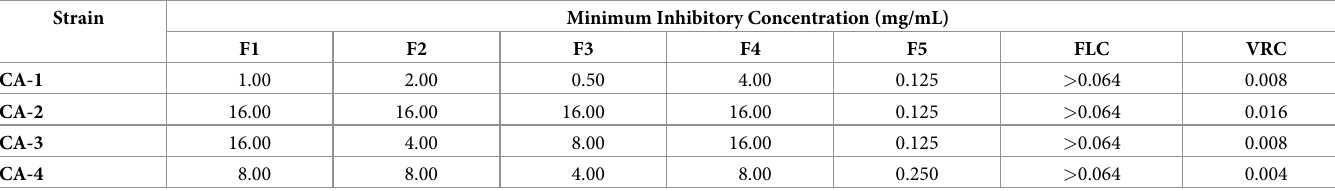
F1, F2, F3, F4 and F5: Column fractions of the chloroform-partitioned fraction of S . torvum ethanol fruit extract (STF-CHCl 3 ). FLC: Fluconazole; VRC: Voriconazole. Experiment was carried out in triplicate.